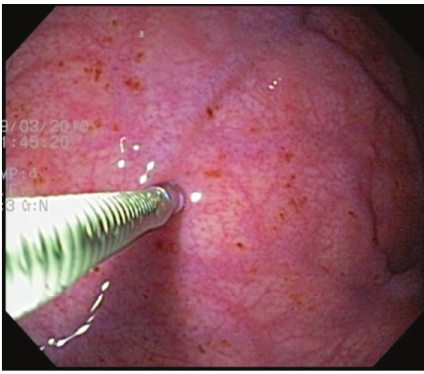
Figure 3: Intragastric botulinum toxin injection. Both the antrum and fundus need to be treated for optimal